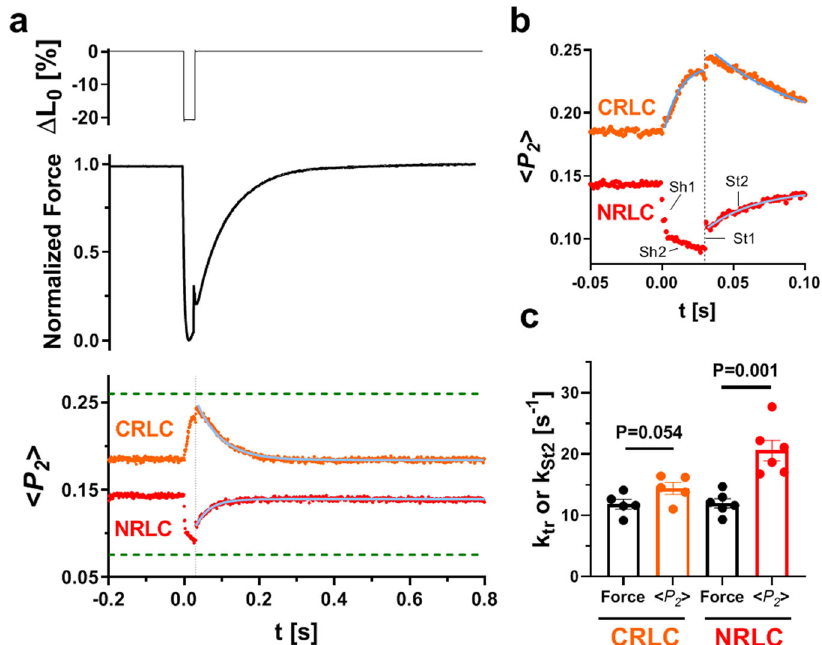
Fig. 2 Changes in orientation of the NRLC and CRLC probes in ventricular trabeculae in response to rapid shortening and re-stretch. a Length change ( Δ L 0 ), normalized force and < P 2 > in trabeculae exchanged with the NRLC (red) and CRLC probe (orange). Probe orientations in the absence of calcium (pCa 9) are indicated as green dashed lines. b < P 2 > responses on an expanded time scale. The initial fast phase (Sh1 and St1) and second slower phases (Sh2 and St2) of the NRLC probe orientation are indicated accordingly. c Rate constants of force re-development (k tr ) or second-phase < P 2 > recovery after the stretch (k St2 ) (means ± s.e.m.; NRLC, n = 6 trabeculae; and CRLC, n = 5 trabeculae). Sarcomere length was set to 2.2 μ m in the relaxed trabeculae. Statistical signi fi cance of differences between force and < P 2 > were assessed with a paired, two-tailed Student ’ s t test. Source data are provided as a Source Data fi